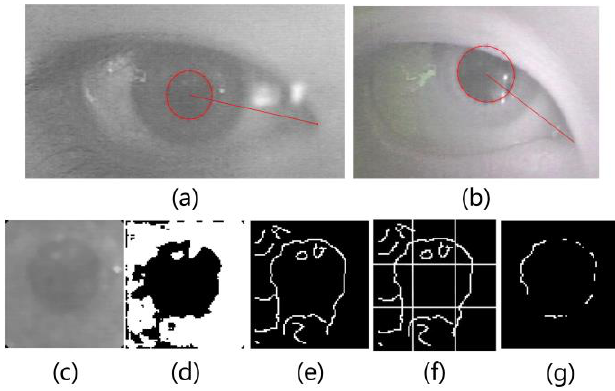
Figure 6. ( a ) represents the extraction of pupil when image with low contrast; ( b ) represents the extraction of the pupil when the pupil is occluded; ( c ) represents the pupil area; ( d ) represents the result of the Otsu method; ( e , f ) represent the preliminary result of pupil edge detection; and ( g ) represents the detection result of the pupil edge.